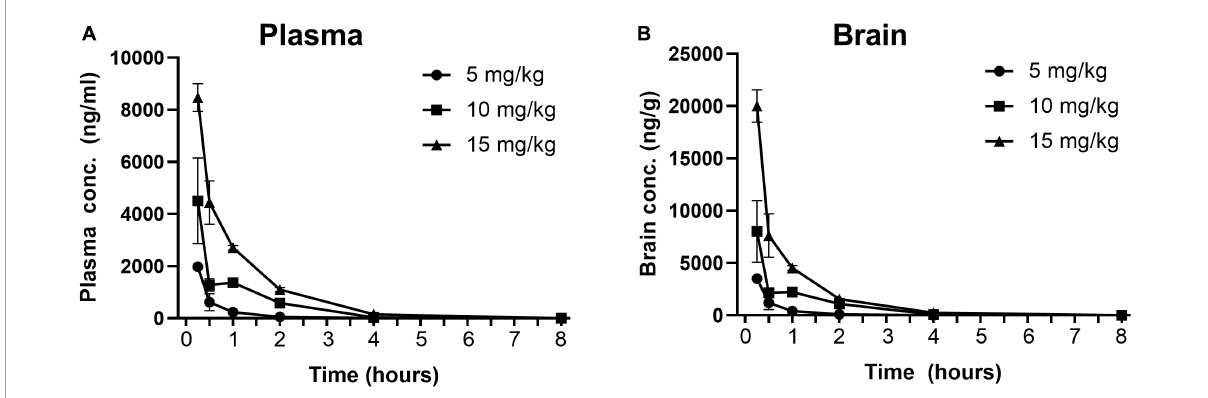
FIGURE2 Concentration-time profiles of methylone in plasma and brain following a single dose. Methylone (5, 10, 15 mg/kg, IP) was administered and terminal blood and brain samples were collected 0.25, 5, 1, 2, 4, and 8 h post-dose. Concentrations of methylone detected in the (A) plasma and (B) brain are shown. Data are presented as means ± SEM. N = 3 per time point per group.